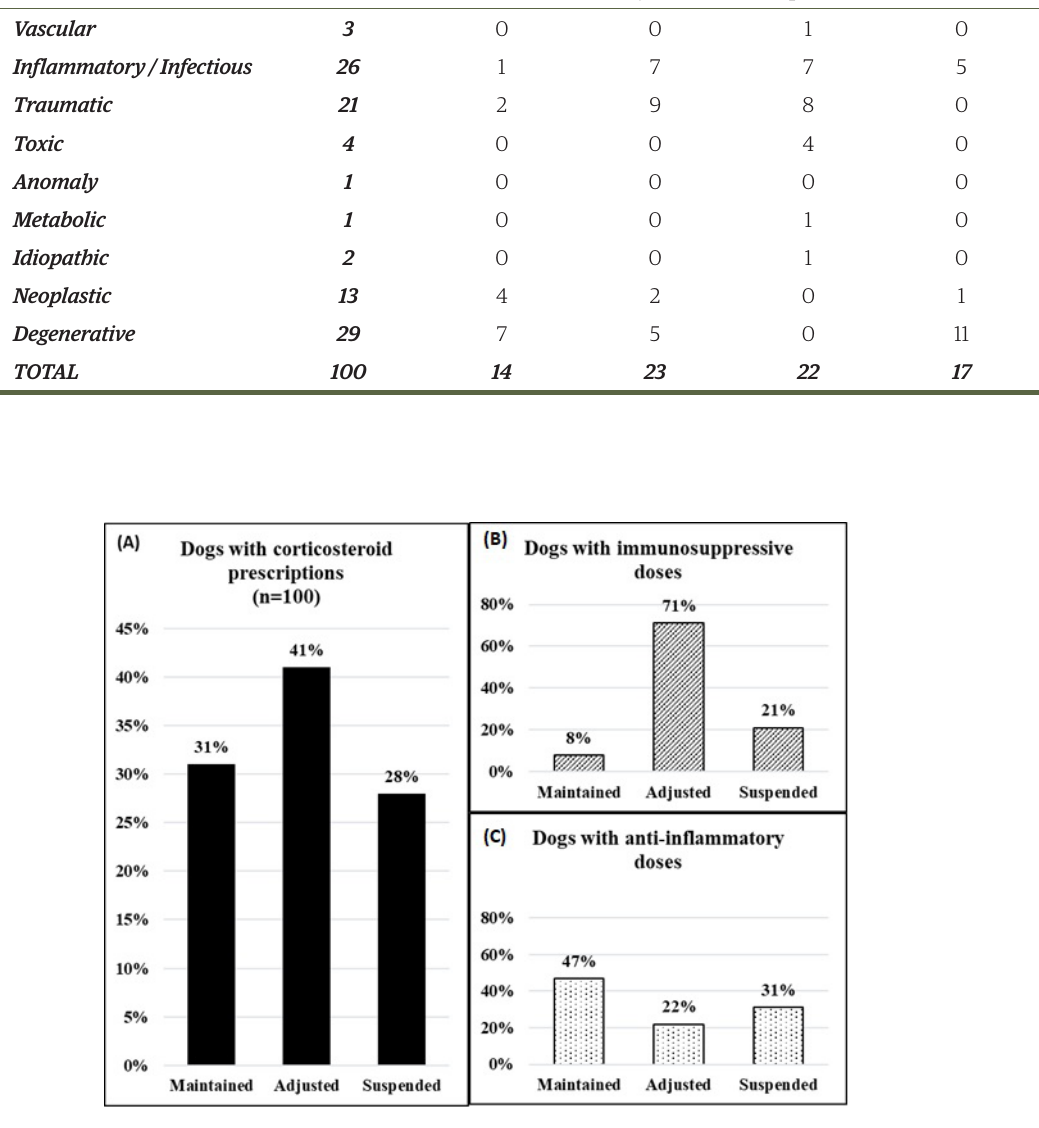
figure 1. Adjustments made to the steroidal therapy prescribed to dogs (n = 100) referred to the Neurology Service at the Veterinary Hospital of UFRRJ, from August 2017 to April 2019. Seropédica,